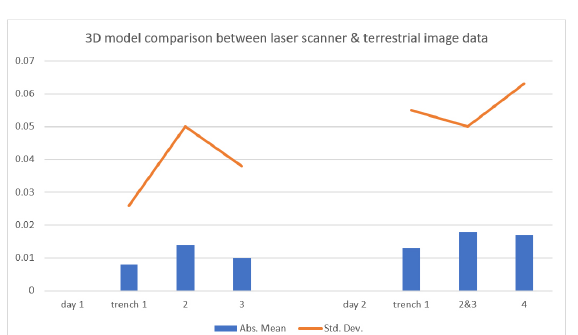
Chart 2 . 3D model comparison between laser scanner and terrestrial image data during the first day (4/7/2019) and the second day (19/7/2019) of the fieldwork.